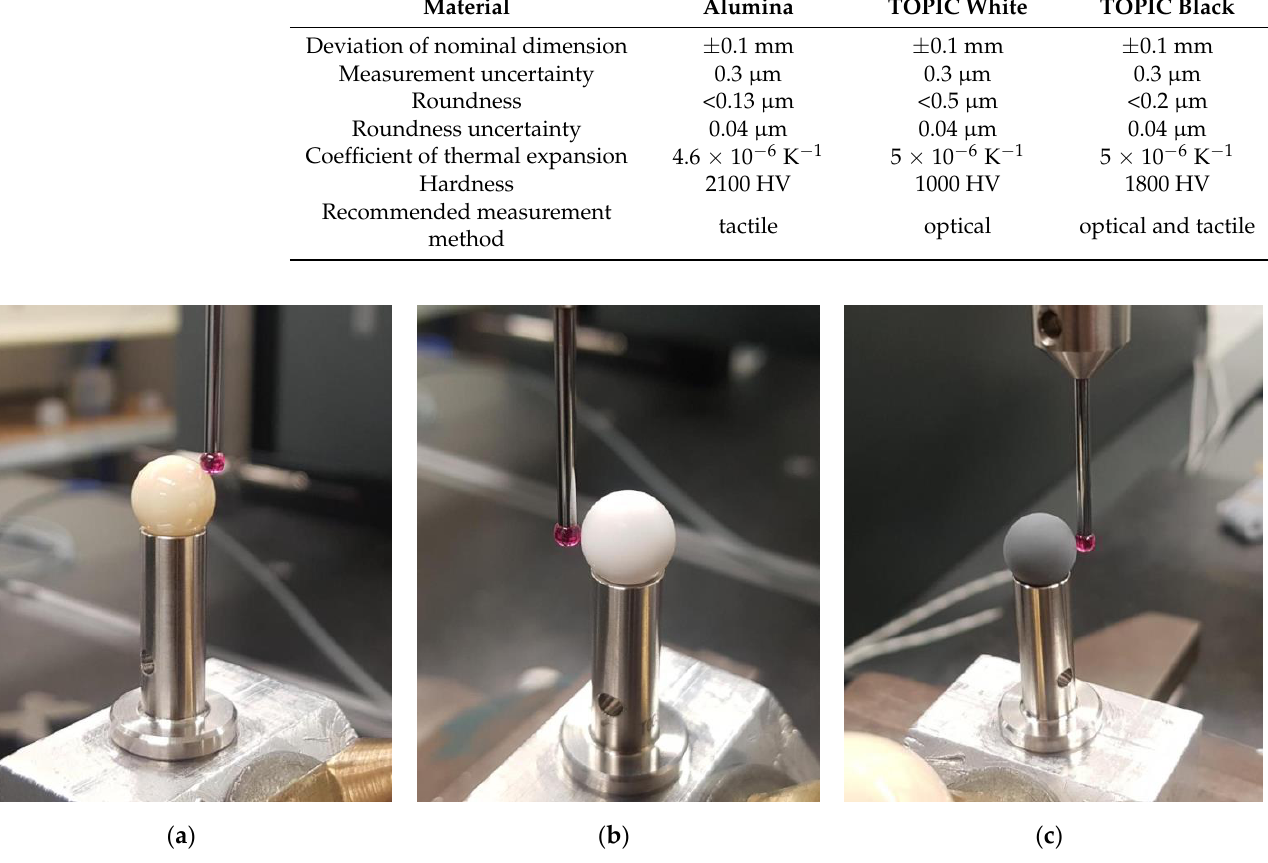
Figure 1. The reference objects that were utilized during experiments: ( a ) Alumina; ( b ) Topic White; ( c ) Topic Black. Table 2. Sensor types, measuring volumes and specifications of CMMs used in experiment. In E E0,MPE column L is measured distance given in